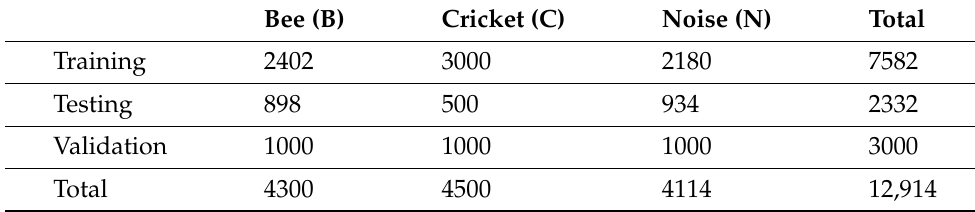
Table 2. Audio sample distribution in